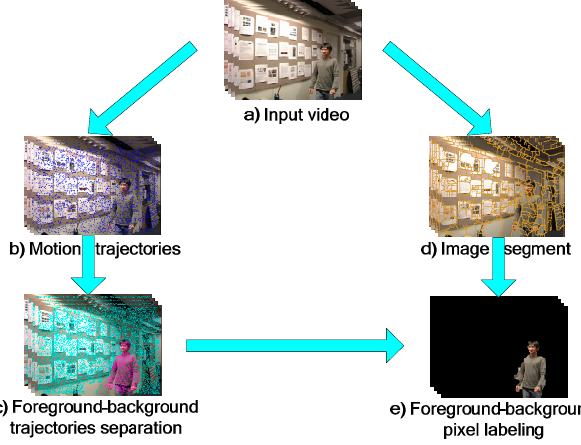
Figure 1. The framework. Our method takes a raw video as input, and produces a binary labeling as the output. Two major steps are initial multi-frame homography model for trajectories classification (left) and final Markov random fields model for foreground background labeling (right).